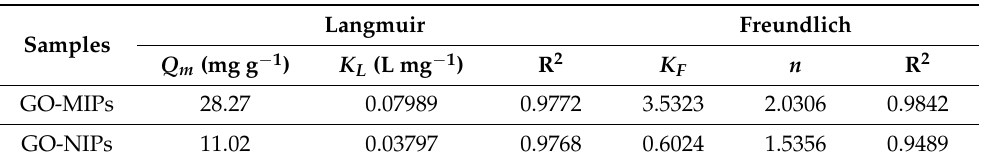
Table 2. Langmuir and Freundlich model adsorption constants of GO-MIPs and GO-NIPs for the adsorption of 4-MEC.